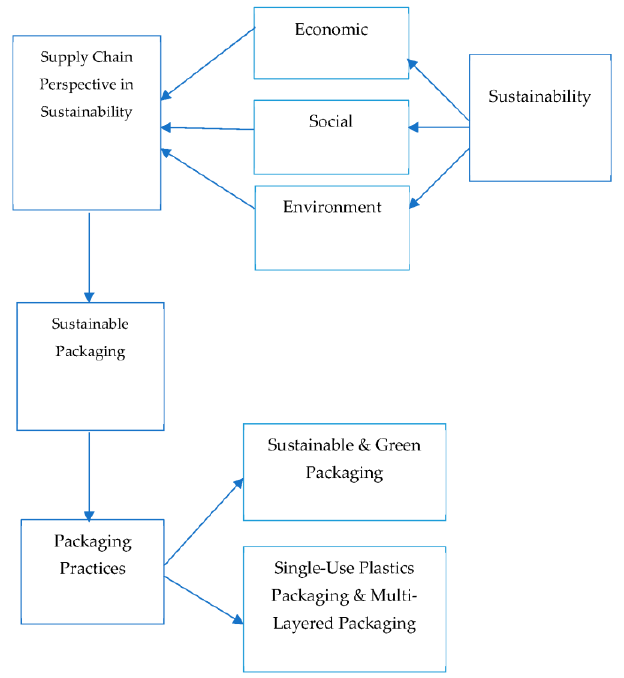
Figure 3. Theoretical framework.